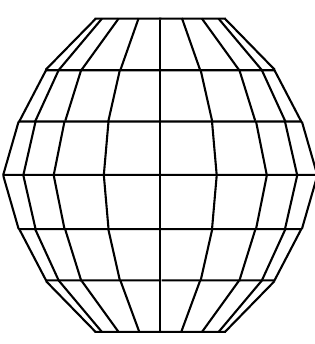
Figure 12. Example two-dimensional discretization in height and azimuthal position of swept surface (side